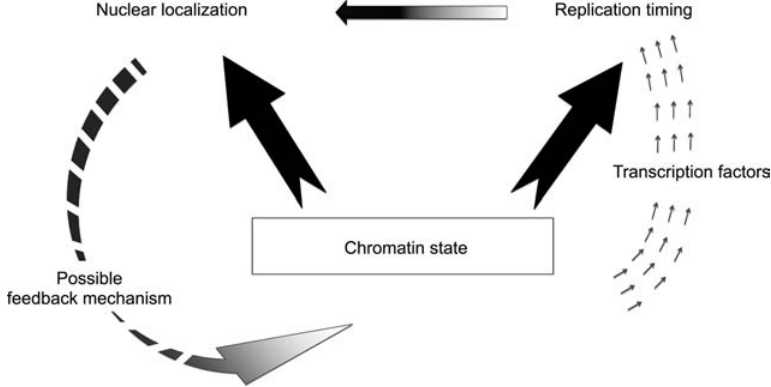
Figure 3 Schematic interplay of epigenetic mechanisms. Changes of the chromatin state, e.g., by incorporating histone acetylation, have been shown to influence the spatial and temporal organization of DNA replication (47, 48). The detailed mechanism of how replication, localization, and timing depend on one another is still unknown, but experiments provide evidence that alterations of the timing of replication lead to altered spatial patterns of replication within a nucleus. Although evidence is missing, a reasonable feedback loop of nuclear localization-dependent DNA replication is thought to act on the chromatin structure. As transcription units often have been found in proximity to origins of replication, the act of transcription and the availability of transcription factors might also be functionally important for the regulation of DNA replication. In yeast it was discovered that an overrepresentation of binding sites of the transcription factors Smp1 and Swi6 correlates with replication origins that are regulated by the HDAC Rpd3L (49). Thus, a possible influence of these and other transcription factors is conceivable either by acting on the gene expression of the HDAC itself or by changing the transcriptional activity of the replicated and transcribed region. This schema demonstrates not a given interconnection, but rather a conceivable network of mechanisms that needs to be analyzed